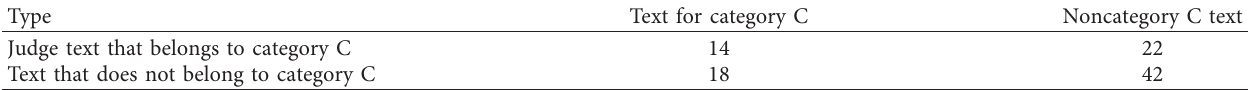
Table 1: Classification result confusion